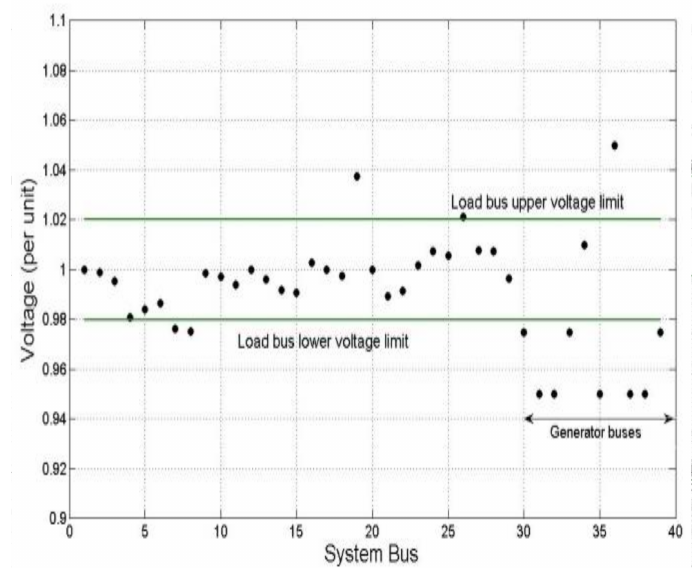
Figure 11. System voltage profile with renewable-energy sources after game